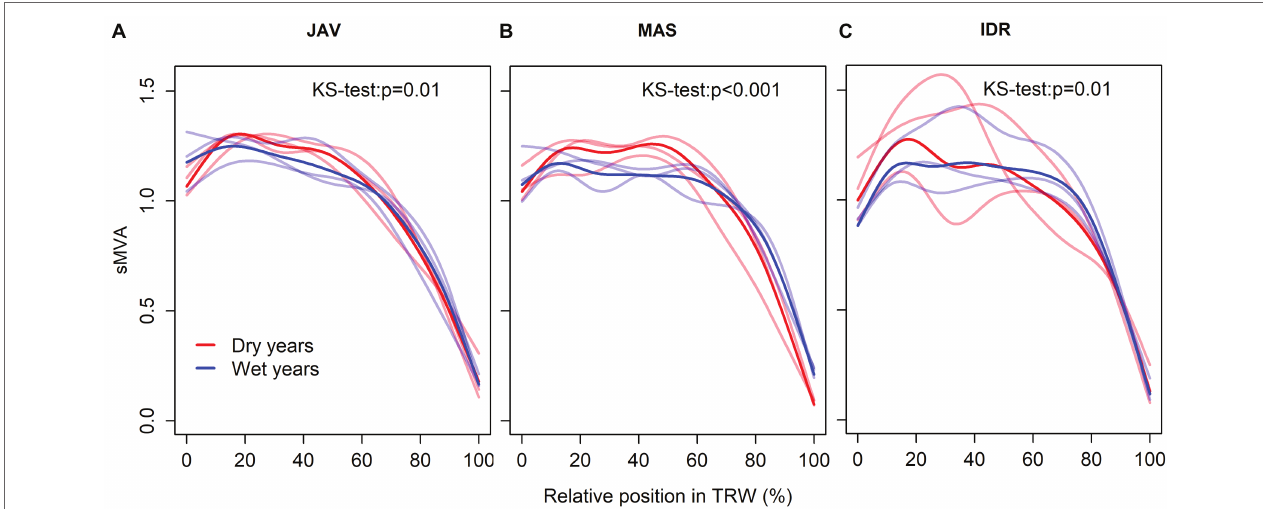
FIGURE 7 | Standardized tracheograms sMVA in common beech for the wettest and the driest summer seasons at the selected sites; (A) Javornik (JAV), (B) Mašun (MAS), and (C) Idrija (IDR). Red and blue lines represent extreme dry and wet years, respectively. Lines with more intensive color represent the mean while transparent lines showing the variability of the selected 3 years for each extreme climate condition. The differences between general additive model (GAM) trends were tested by the Kolmogorov–Smirnov